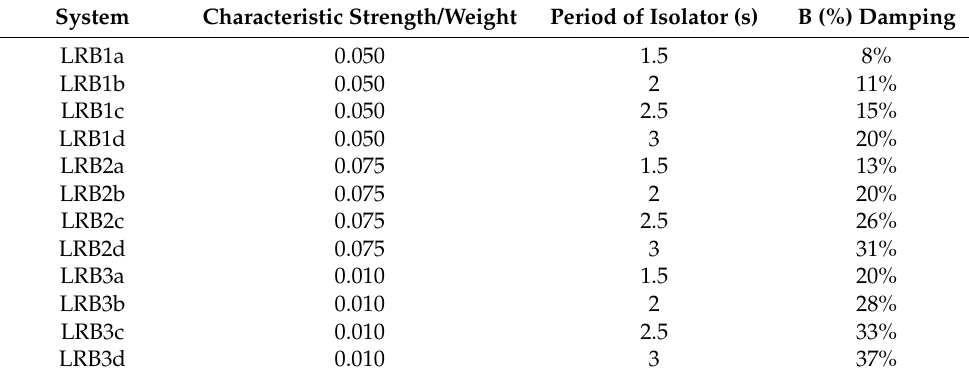
Table 3. Selected LRB system